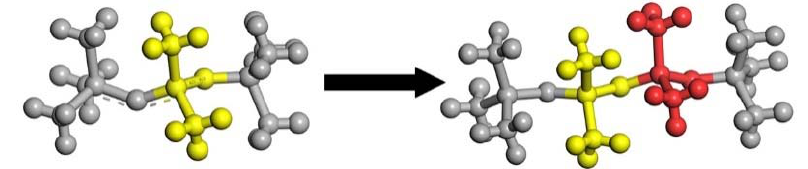
of PDMS molecular chain is shown in Figure 2.